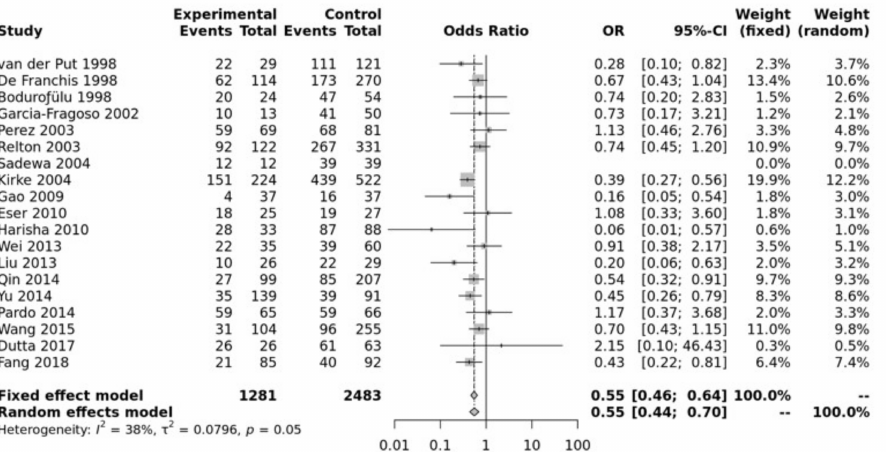
Figure 1. Homozygous model for MTHFR C677T. Van Der Put [34], De Franchis [30], Bodurofulo [23], Garcia-Fragoso [35], Perez [36], Relton [28], Sadewa [37], Kirke [24], Gao [38], Eser [39], Harisha [40], Wei [41], Liu [42], Qin [43], Yu [44], Pardo [45], Wang [46], Dutta [47], Fang [48]. For MTHFR A1298C, none of the models were significant (Figure 2). Egger’s test showed no bias ( p > 0.10) but funnel plots showed heterogeneity (Figure S3).